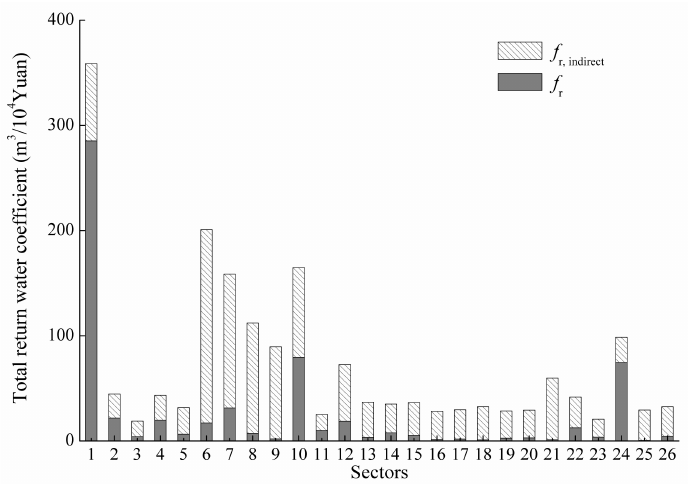
Figure 6. Change trends of total return water coefficients from 2002 to 2012.